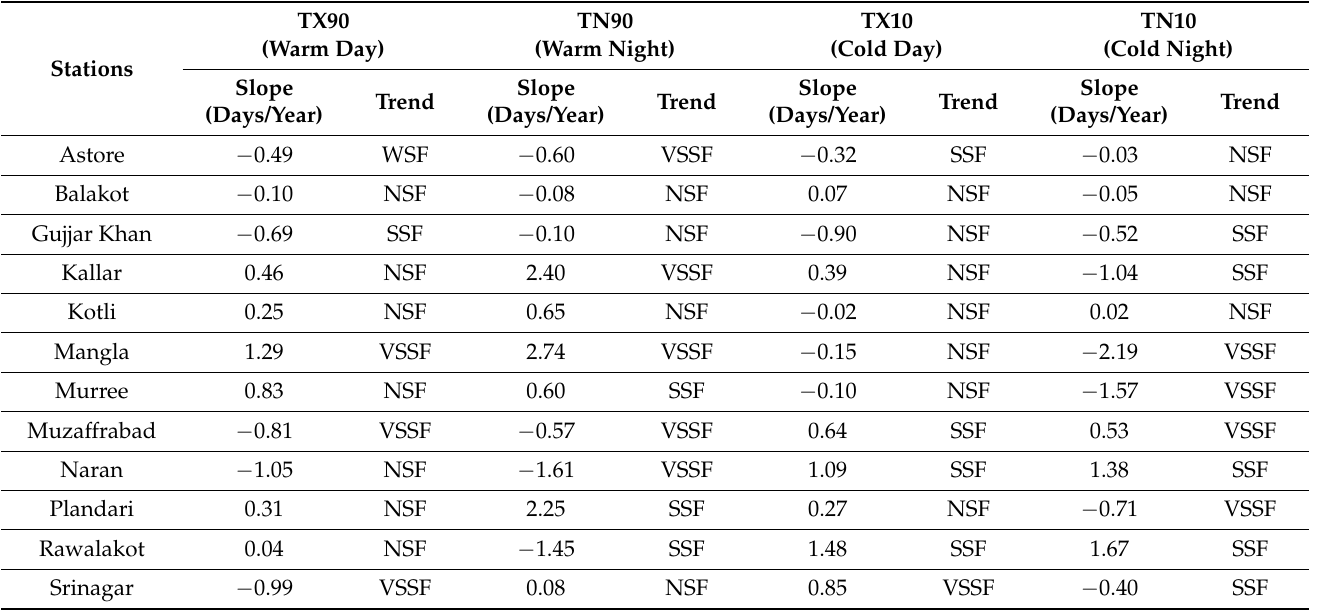
Table 6. Relative temperature indices slopes and